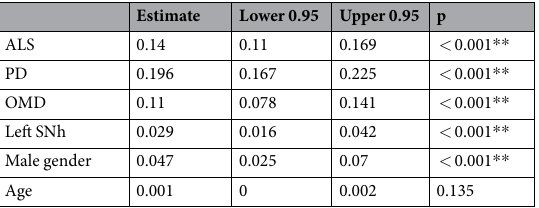
Table 2. Mixed lineal regression model that analyses differences in the SNh area between controls and subgroups of patients. ALS: amyotrophic lateral sclerosis; OMD: other movement disorders (atypical parkinsonism, vascular parkinsonism and essential tremor); PD: Parkinson’s disease; SNh: hyperechogenicity of substantia